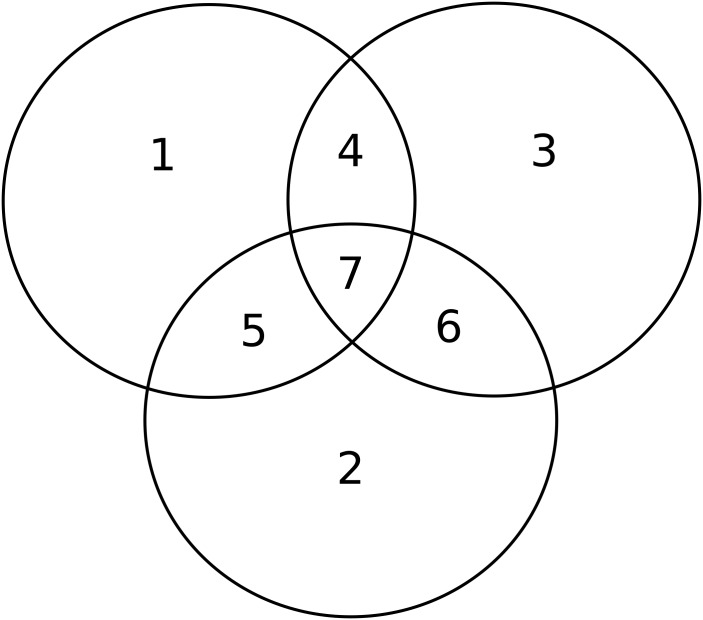
A visualization of super-category II of the B datasets.All three super-categories have seven constructed regions of overlap, this visualization shows the proportional overlap for the categories D, E, and F that make up super-category II. Category D is a union of the possibly active input lines from sub-regions 1, 4, 5, and 7. Similarly, Category E is a union of the possibly active input lines from sub-regions 2, 5, 6, and 7. Lastly, Category F is a union of sub-regions 3, 4, 6, and 7. Note that 30 input lines define sub-region 1, 10 define sub-region 4, which is shared between D and F, 10 define sub-region 5 which is shared between D and E, and 10 define sub-region 7 which is shared by D, E, and F.